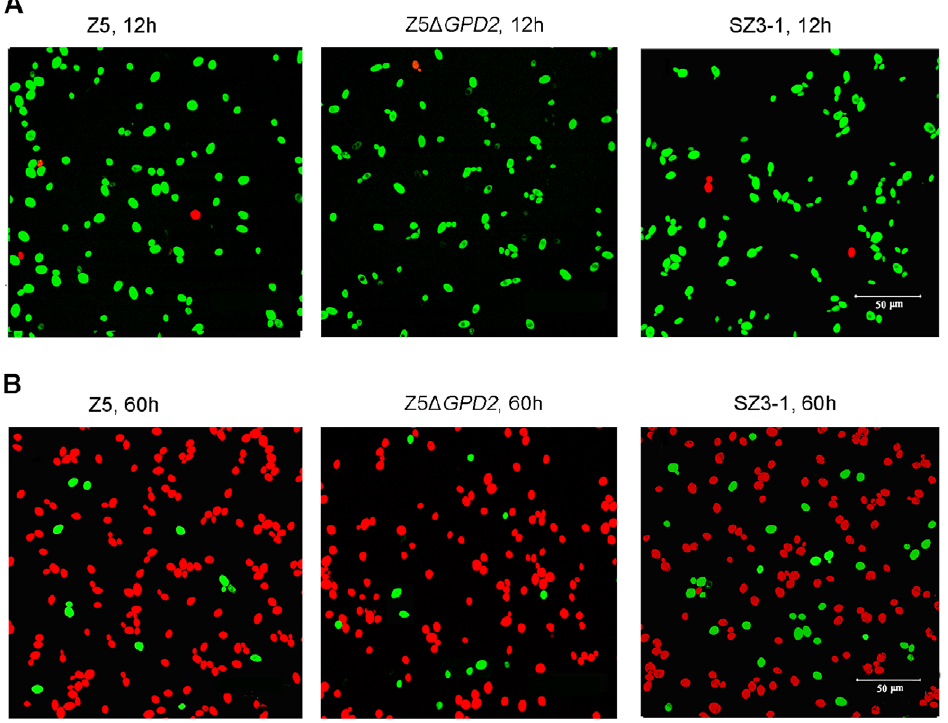
Figure 2. Cell membrane integrity of strains Z5, Z5 D GPD2 and SZ3-1 at different time of fermentation. Yeast cells harvested at 12 h (A) and 60 h (B) of fermentation, respectively, were stained with PI and FDA. Viable cells were stained green with FDA and the cells that had lost membrane integrity were stained red with PI. doi:10.1371/journal.pone.0031235.g002 PLoS ONE |